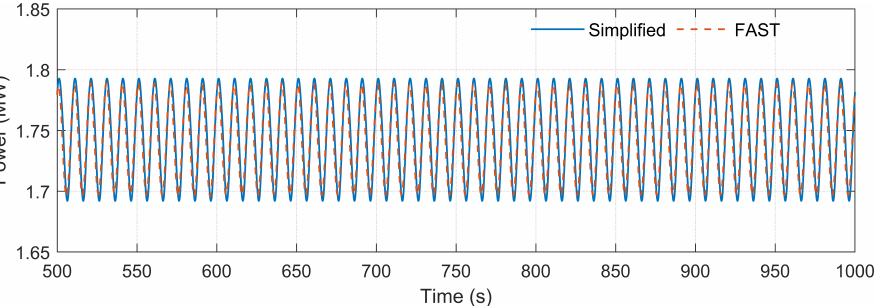
Figure 15. Output power of the spar-buoy floating turbine under regular wave and wind speeds of 8 m/s.